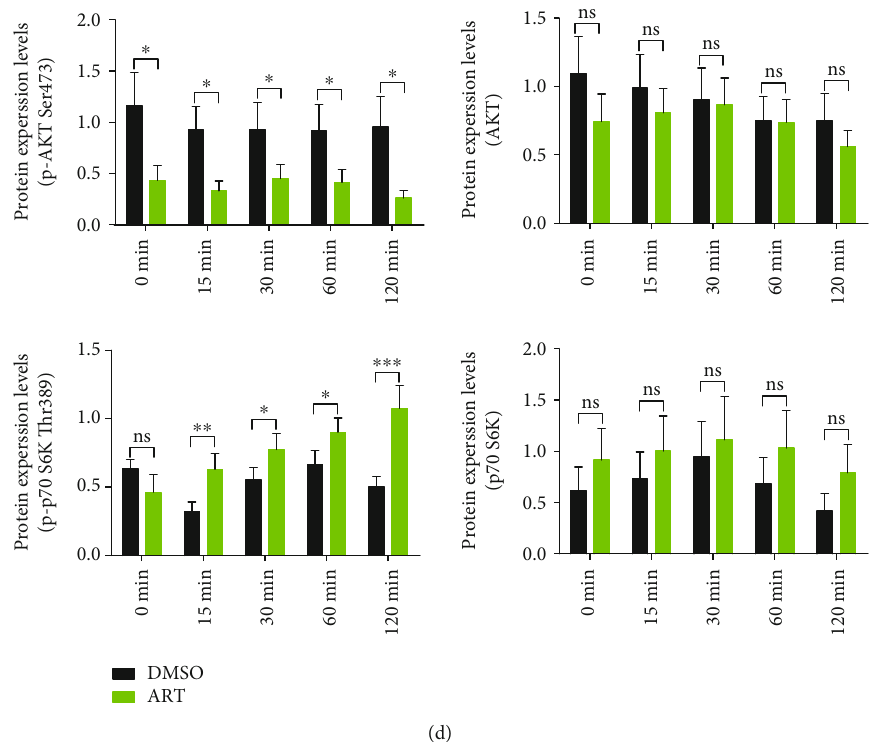
Figure 3: ART controls the functional polarization of MDSCs through PI3K/AKT, mTOR, and MAPK pathways. (a and c) Puri fi ed CD11b + Gr-1 + MDSCs from the tumors of B16F10-bearing C57BL/6 mice for 13 days and then treated MDSCs with DMSO or ART (100 μ M) in vitro for di ff erent time points. (a) Western blot was used to detect MAPK signal pathway-related proteins p-ERK (Thr202/ Tyr204), ERK, p-p38 MAPK (Thr180/Tyr182), and p38 MAPK. (b) Gray value statistics. (c) PI3K/AKT and mTOR signaling pathway- related proteins p-AKT (ser473), AKT, p-p70 S6K (Thr389), and p70 S6K were detected by western blot. (d) Gray value statistics. Data are means ± SEM and are from a representative experiment of three (a and c). Unpaired Student ’ s t test for (b) and (d). ∗ P < 0 : 05 , ∗∗ P < 0 : 01 , and ∗∗∗ P < 0 : 001 . ns: not signi fi